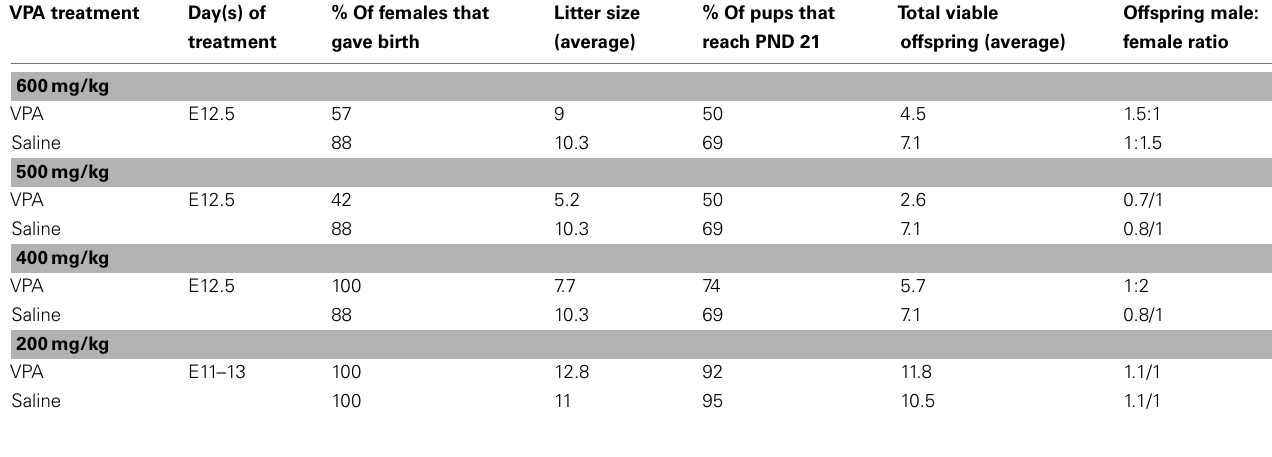
Table 1 | Summary of success ofVPA administration